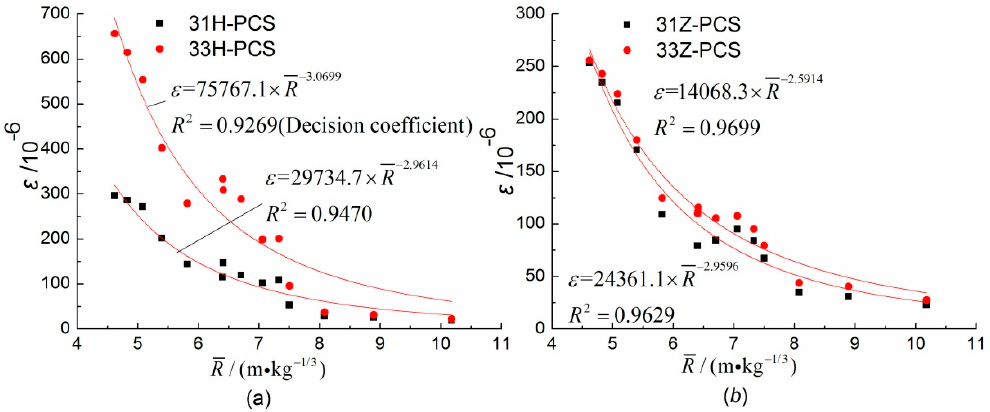
Figure 4. PCS of 31H, 31Z, 33H, and 33Z ( R = 2.7 m and R = 3.75 m).